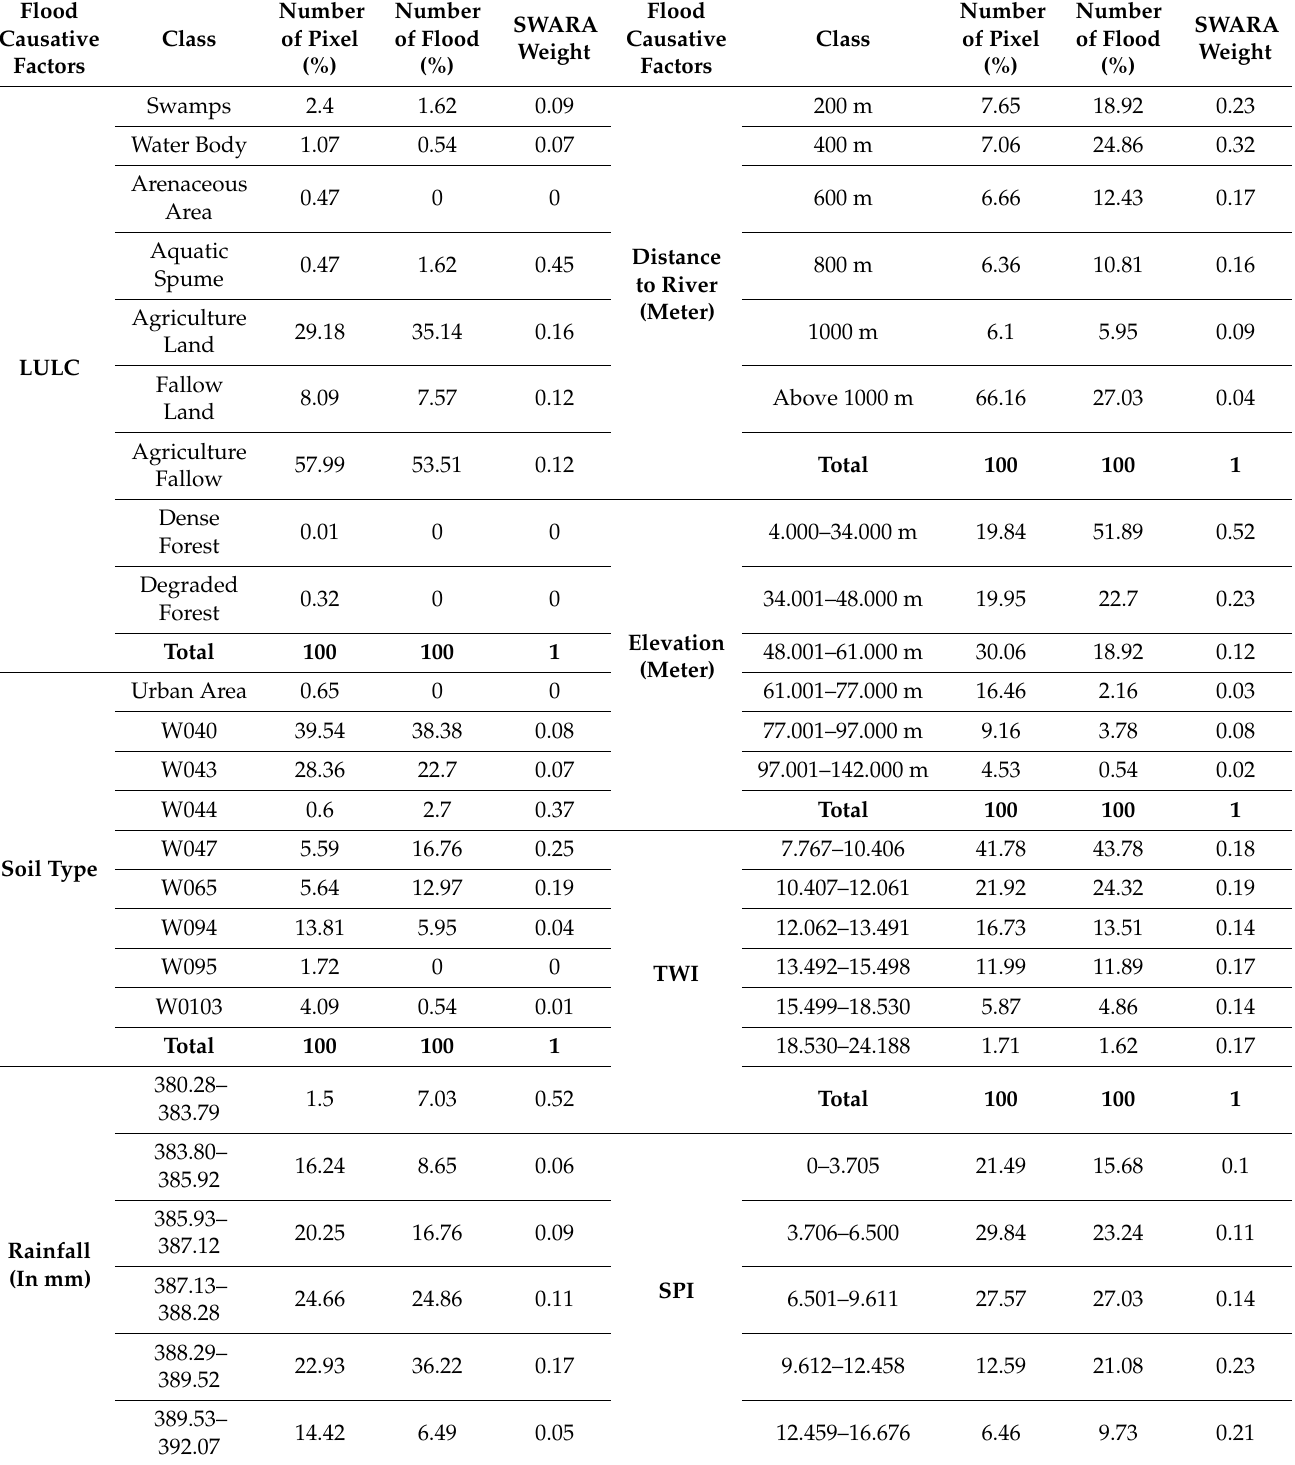
Table 5. Step-wise weight assessment ratio analysis (SWARA) weight of flood causative